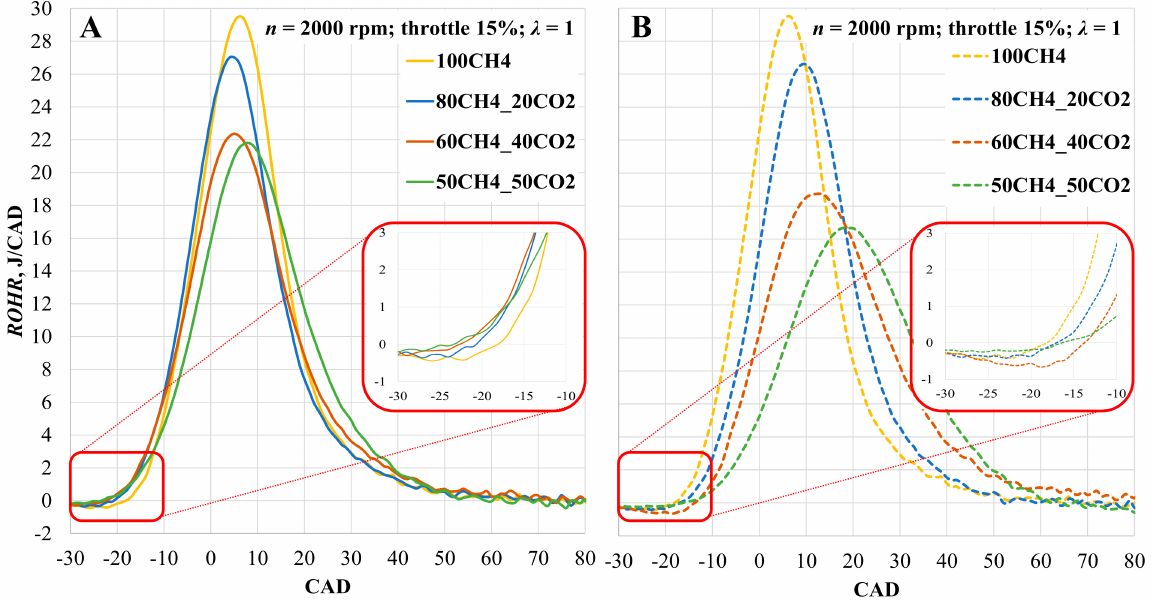
Figure 3. ROHR in the cylinder depending on simulated BG composition and ST. ( A )—with optimal ST for mixture; ( B )—with optimal CNG